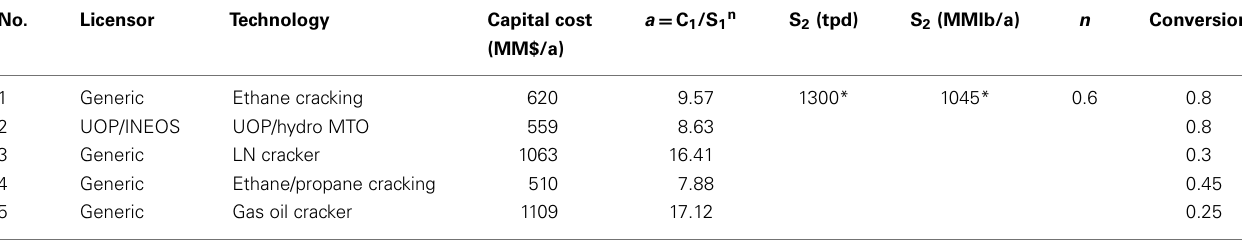
Table 3 | Historical data for order-of-magnitude cost estimation (Towler and Sinnott, 2013) .